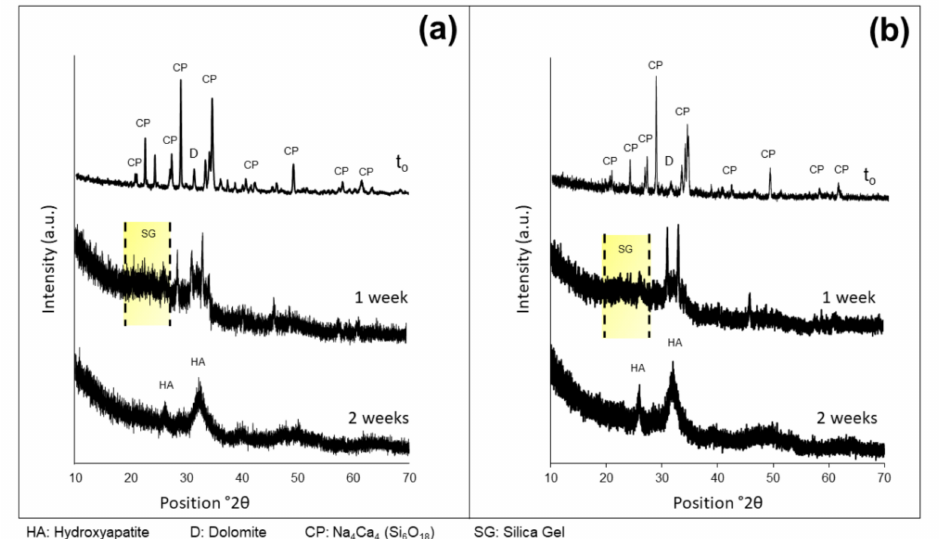
Figure 6. XRD patterns after immersion in SBF at di ff erent time points related to D-800 ( a ) and D-850 ( b ) sca ff olds. CP = crystalline phase (Na 4 Ca 4 (Si 6 O 18 )) of sintered glass-ceramic sca ff old; D = residual dolomite; SG = halo associated to the silica gel layer; HA =